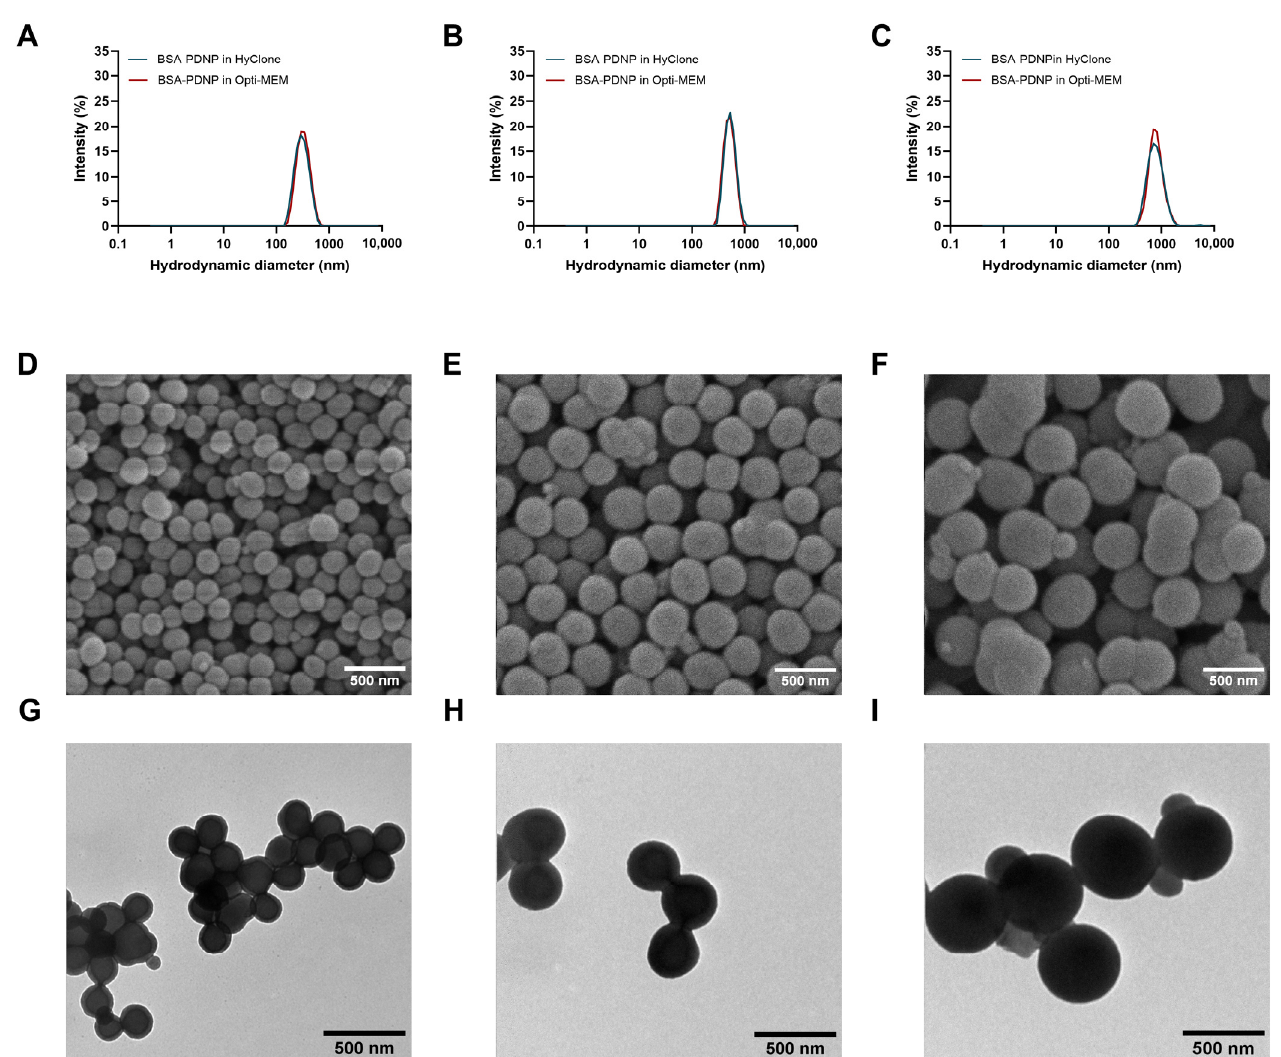
Figure 2. Size and morphology characterization of BSA-coated polydopamine nanoparticles (PDNPs) of various sizes. ( A – C ) Representative intensity size distributions as measured by DLS of BSA-coated PDNPs of 300 nm ( A ), 500 nm ( B ) and 700 nm ( C ) in water (blue) and 15 min incubated in Opti-MEM (red). ( D – F ) Representative SEM images of BSA-coated PDNPs of 300 nm ( D ), 500 nm ( E ) and 700 nm ( F ). Scale bar = 500 nm. ( G – I ) Representative TEM images of BSA-coated PDNPs of 300 nm ( G ), 500 nm ( H ) and 700 nm ( I ). Scale bar = 500 nm.